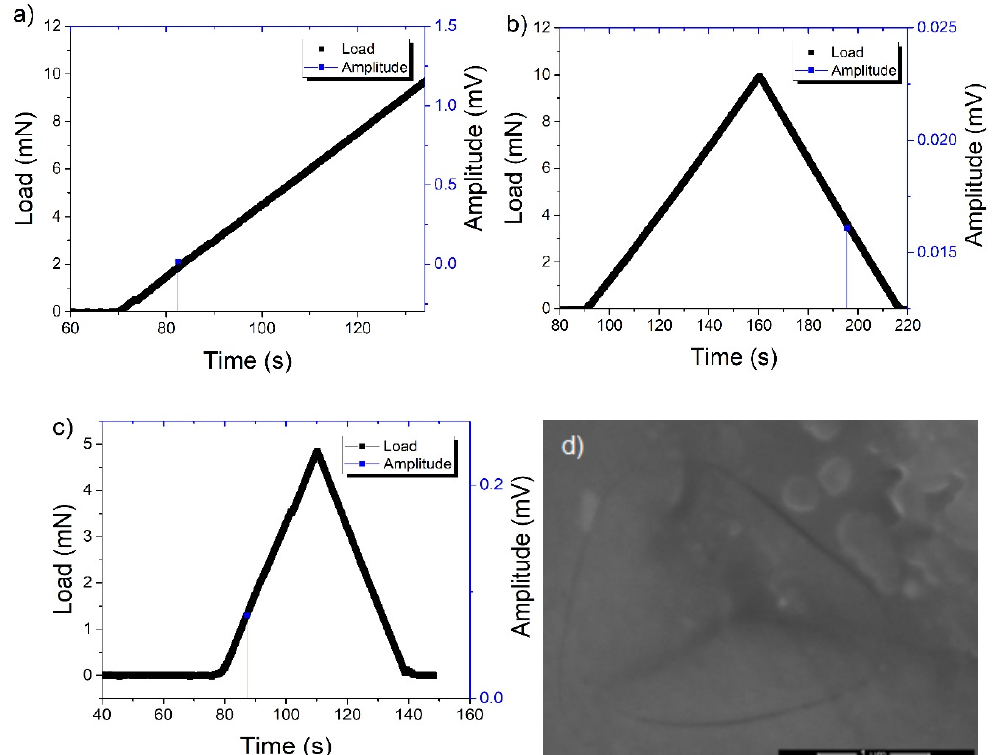
Figure 7. Load and acoustic emission amplitude signals as a function of time for the 10 mN inden- tation for the 200 °C layer and 300 °C layer ( a ) and ( b ), respectively. ( c ) Load and AE amplitude as a function of time for the 5 mN touch on the 200 °C MoO 3 layer; ( d ) SEM image of the crack after the indentation.